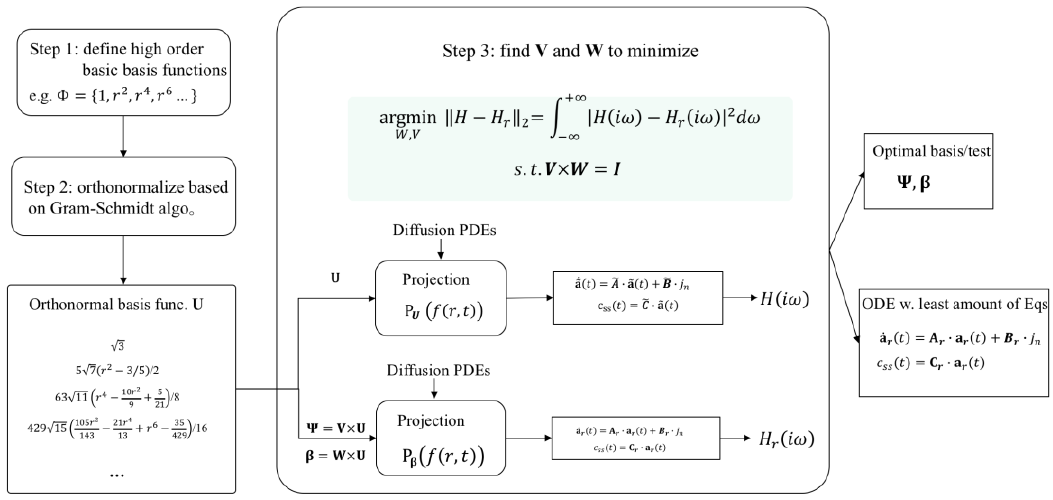
Figure 4. Flowchart of the optimal projection method for solving diffusion PDEs.